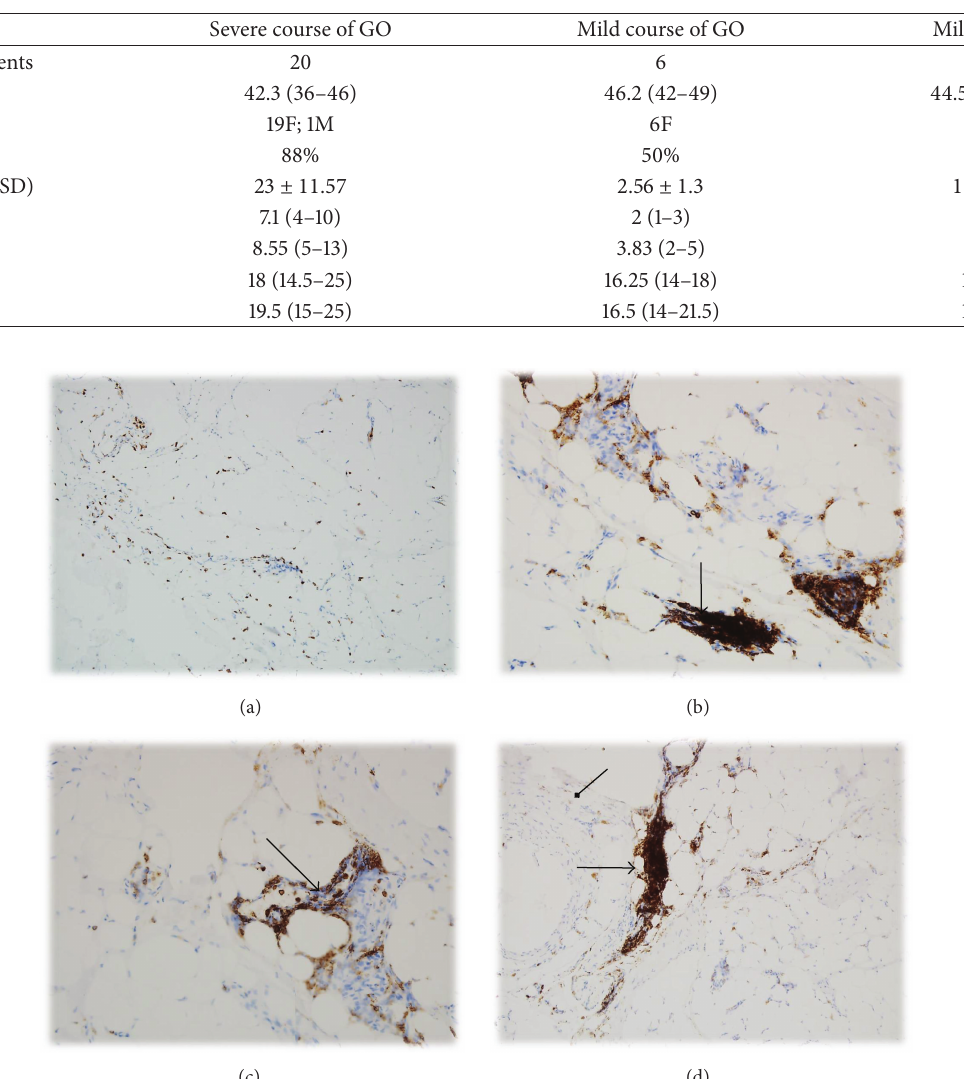
Table 1: Characteristics of patients.